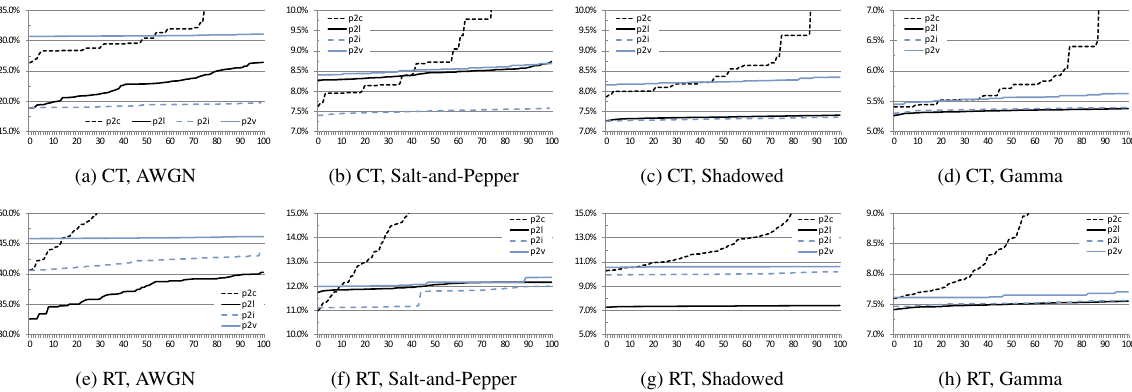
Figure 7: Errors in unoccluded areas for all penalty functions on degenerated input images employing census and rank transform.